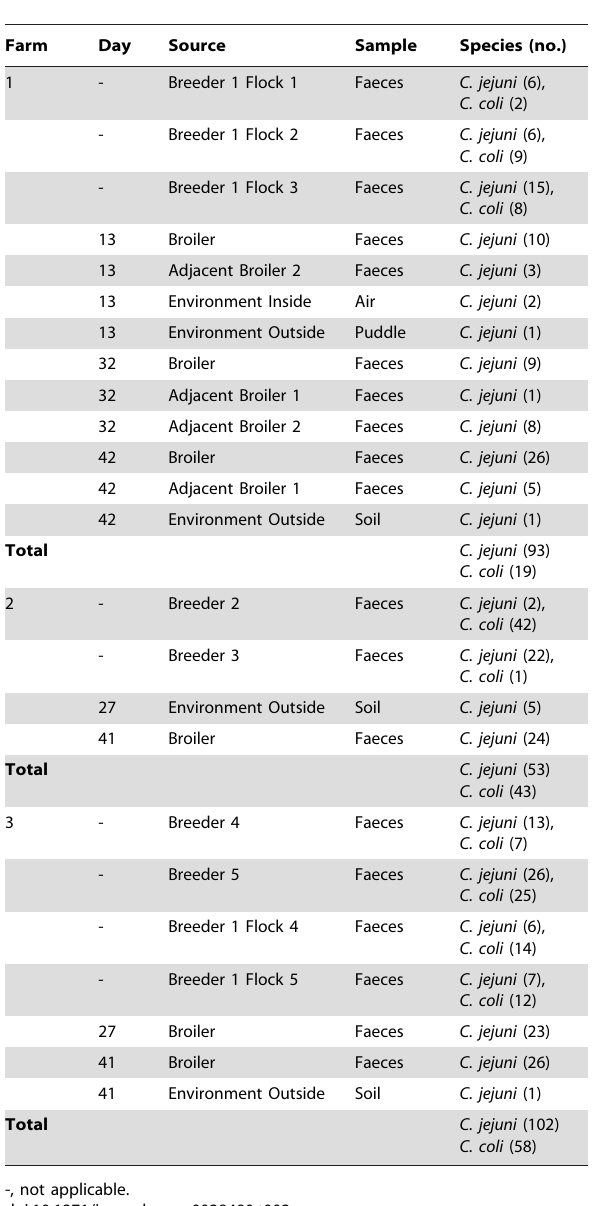
Table 2. Campylobacter species recovered from all farms